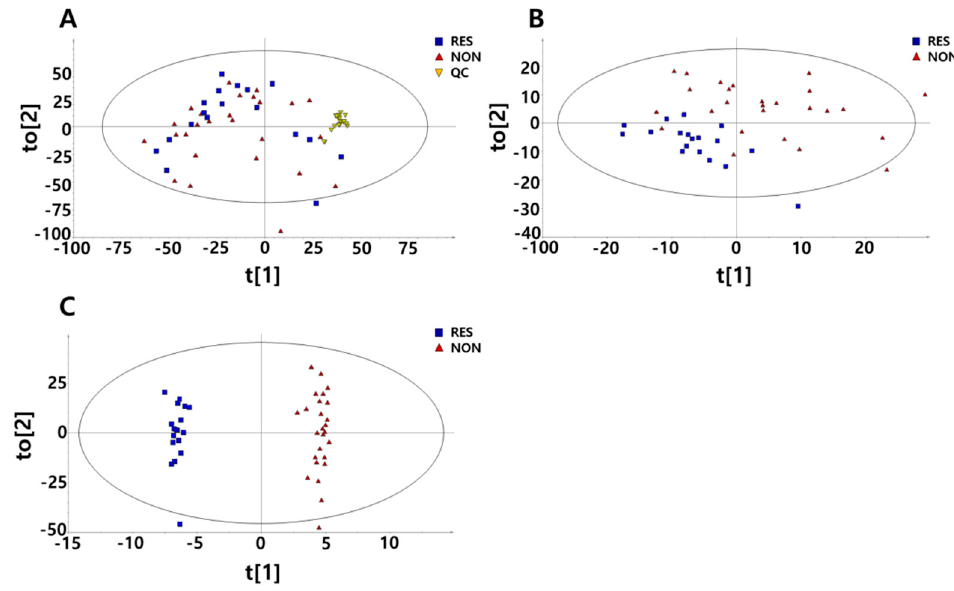
Figure 1. Multivariate analyses derived from untargeted metabolic profiling using gas chromatography/mass chromatography (GC/MS). Data are shown for 9 responders and 13 non-responders before and after 3 months of metformin treatment. ( A ) Principal component analysis (PCA) with 18 additional pooled urine samples added for quality control (QC). ( B ) Partial least squares-discriminant analysis (PLS-DA) score plots divided into responders and non-responders to metformin. ( C ) orthogonal PLS (OPLS)-DA score plots divided into responders and non-responders to metformin.